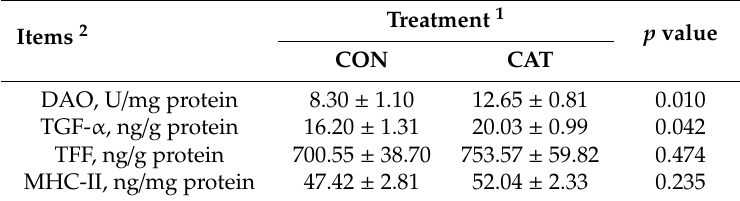
Table 4. E ff ects of dietary exogenous catalase supplementation on jejunum mucosal factors in weaned piglets. Items